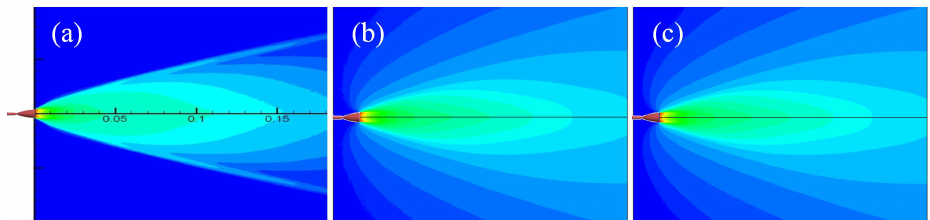
Figure 2. Schematic of the vacuum plume generated at the background pressure of ( a ) 1 Pa, ( b ) 2.5 × 10 − 3 Pa, and ( c ) 0 Pa, which are simulated by